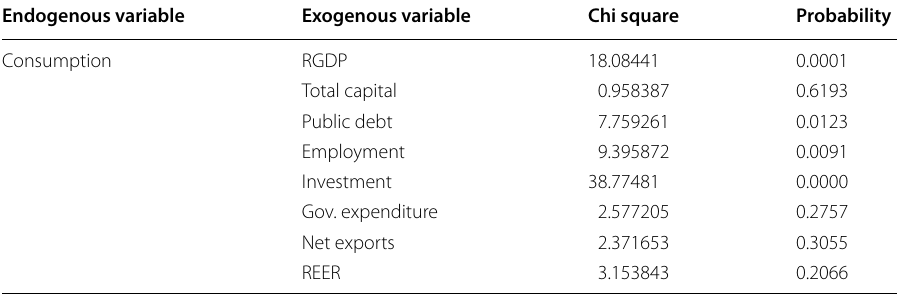
Table 8 Wald test results for Eq. (4). Source : Author’s calculations